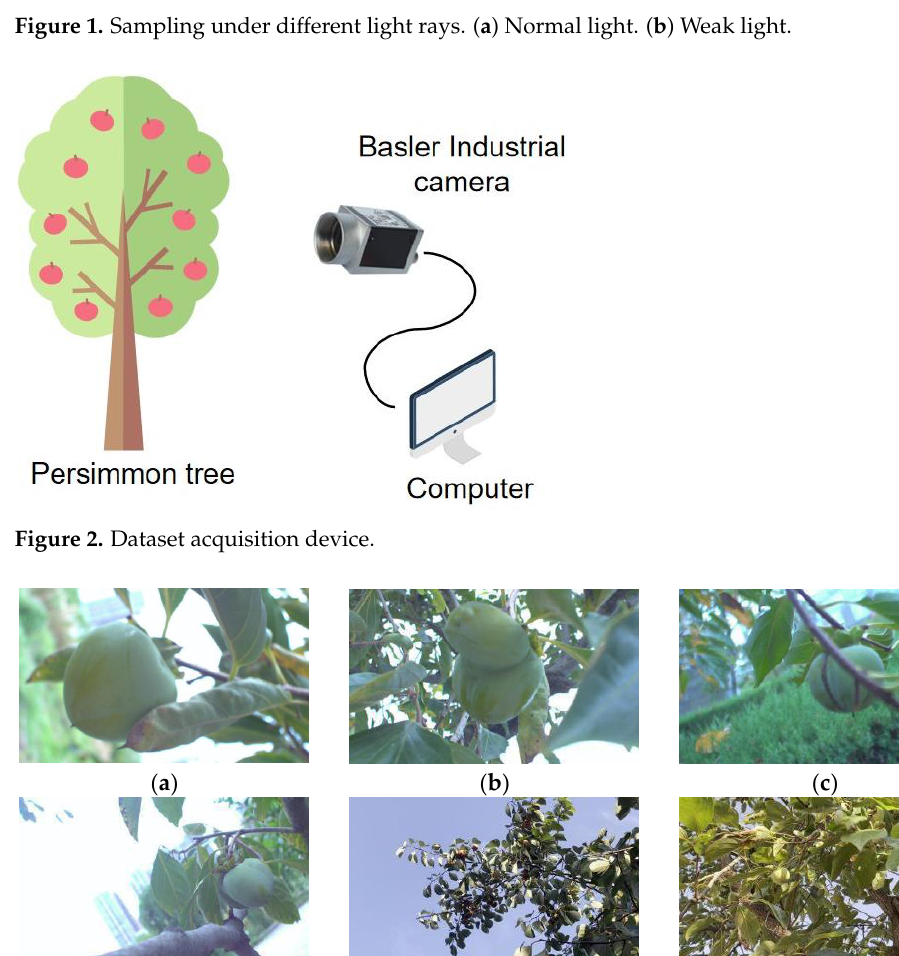
( f ) Figure 4. The enhancement effect on a persimmon image: ( a ) original image; ( b ) sharpness reduc- tion; ( c ) brightness enhancement; ( d ) brightness reduction; ( e ) added noise; and ( f ) flip. 3. An Improved YOLOv5 Model 3.1. Mosaic Data Augmentation Mosaic data augmentation can randomly select four images to scale, cut, and arrange to achieve re-stitching, as shown in Figure 5. YOLOv5 continues the Mosaic data augmen- tation method of the previous version, which greatly enriches the datasets and increases the robustness of the model. At the same time, random scaling and cropping techniques also improve the detection accuracy of small objects, thereby improving the overall detec- tion effect.